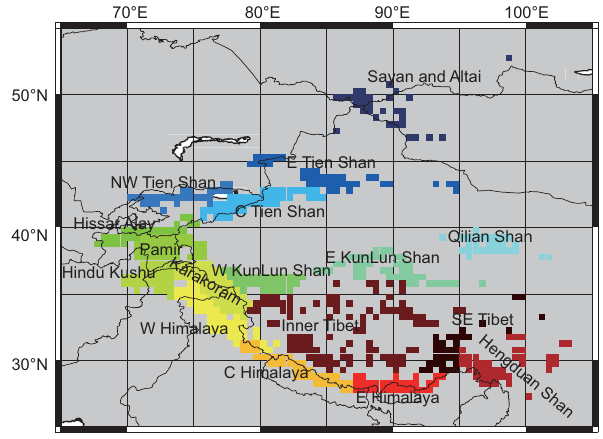
Figure 1. Study area: high-mountain Asia. Region name and loca- tion of the grid that the GGI